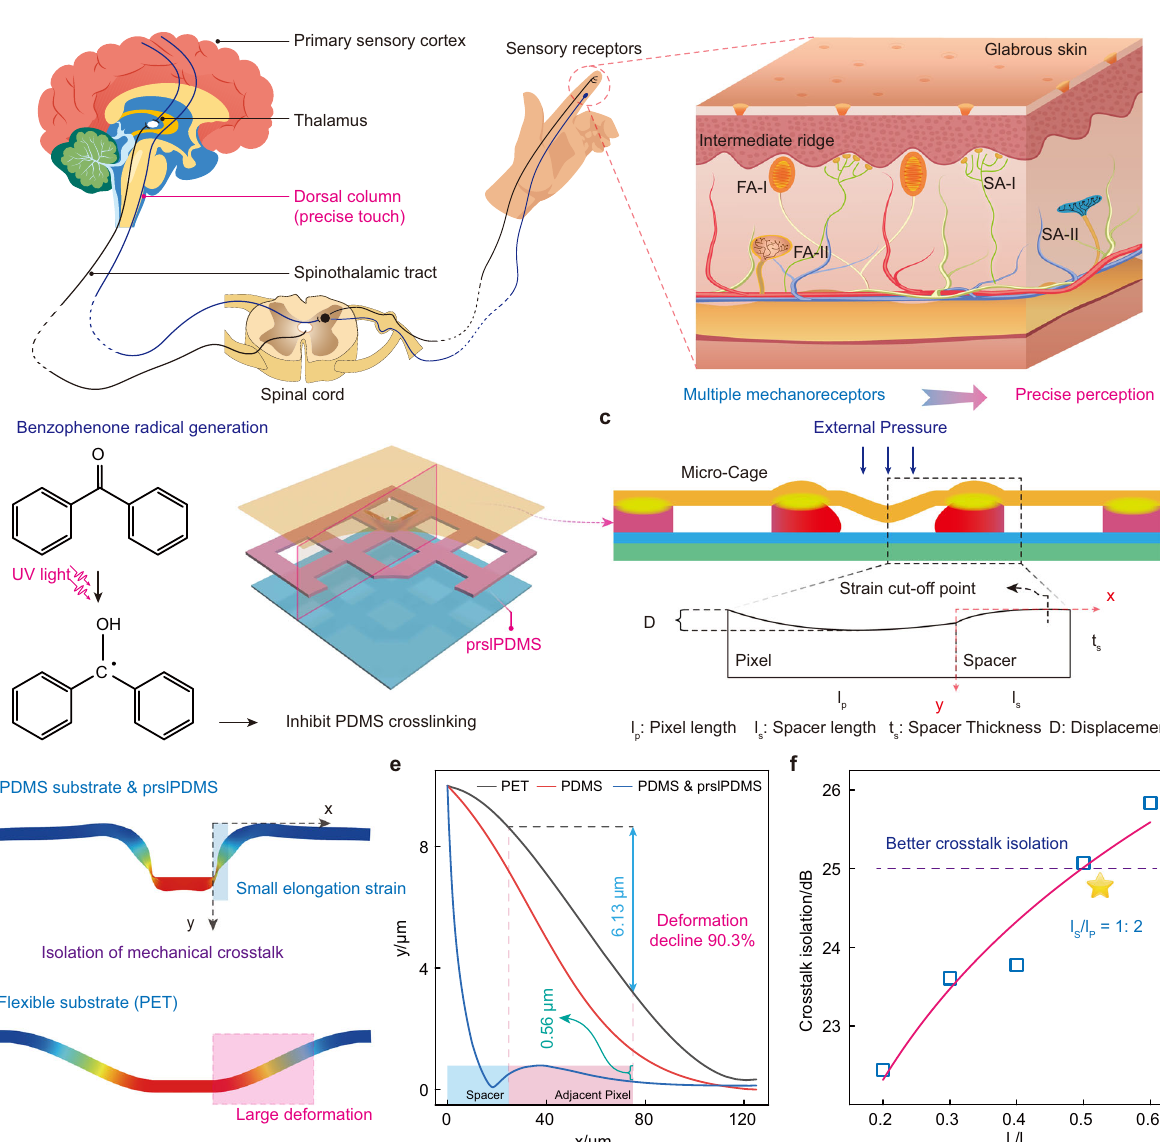
Fig. 1 | Principle of ultralow crosstalk sensor with micro-cage structure based on prslPDMS layer. a Schematic illustration of multiple mechanoreceptors in glabrous skin for accurate tactile perception. b Proposed chemistry of benzophe- none inhibiting PDMS cross-linking under UV light to prepare prslPDMS layer. c Simple geometric analysis of micro-cage structure formed by prslPDMS under externalpressure. d Two-dimensionaldeformationsimulationanalysisofthePDMS